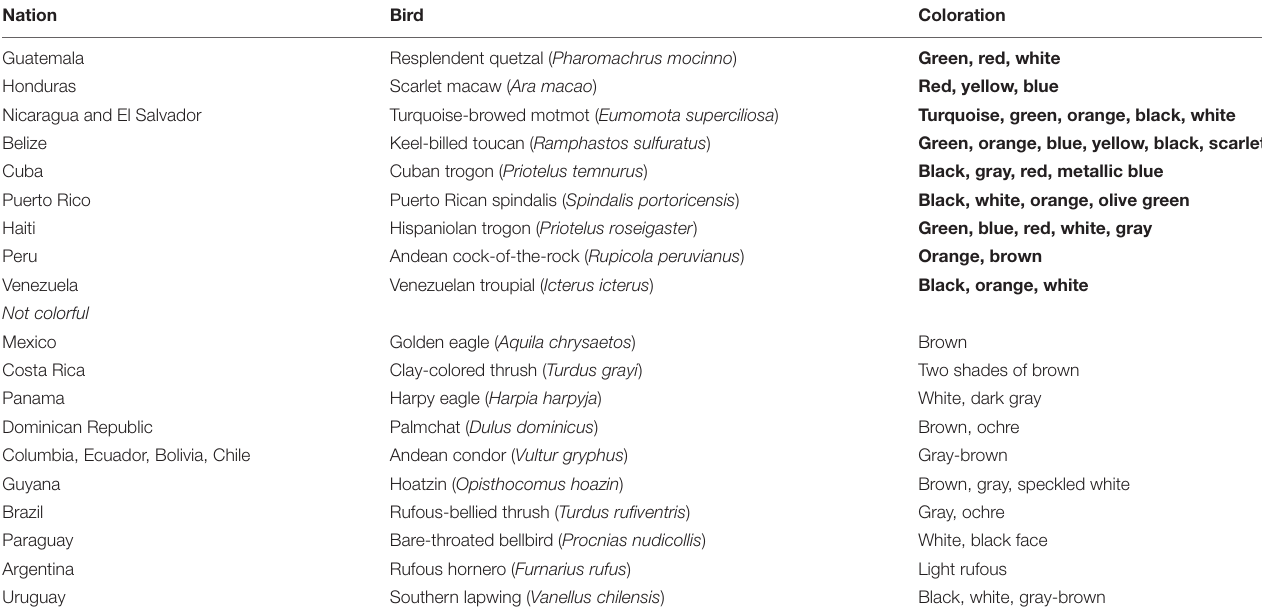
Bold indicates colorful species.